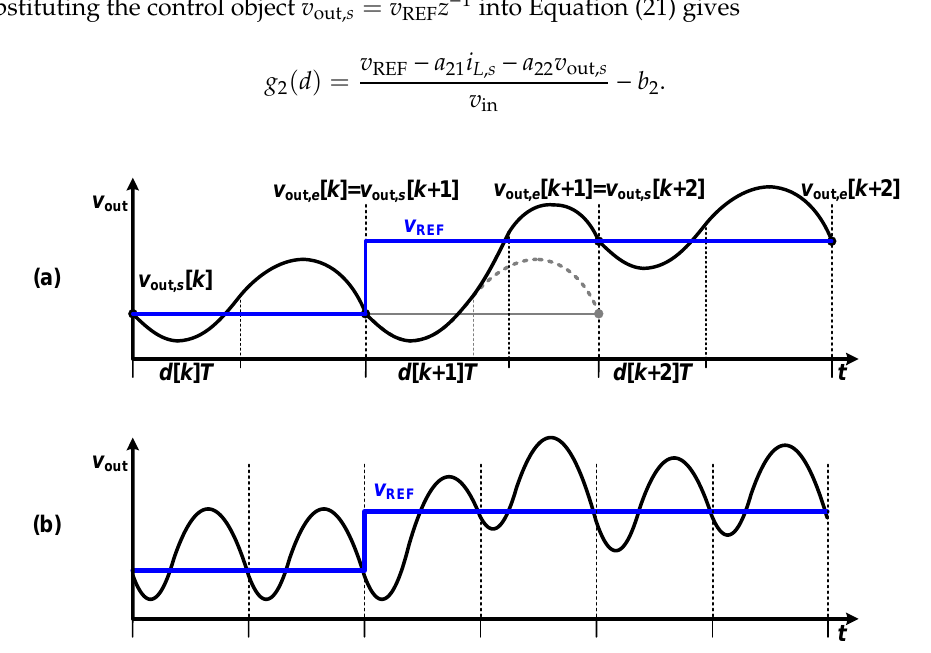
Figure 6. Output voltage under DPVP control: ( a ) Ideal condition and ( b ) Matlab-Simulink simulation with a consideration of parasitics.